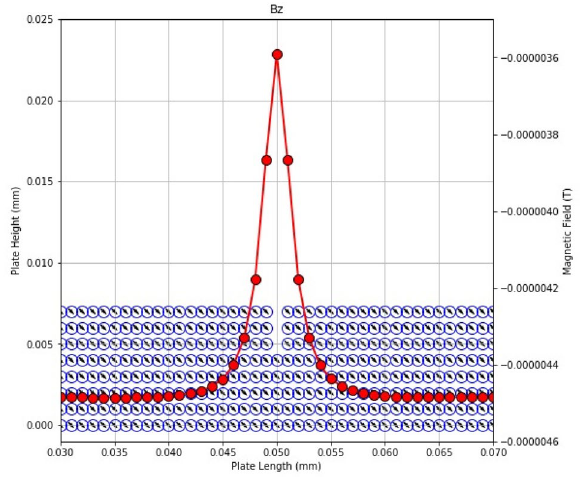
Fig. 13 Experimental result of magnetic field X of a rectangular defect A1 with ordered magnetic domains